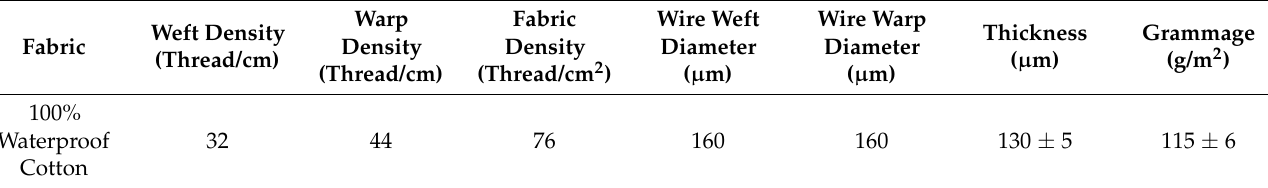
Table 2. Fabric characteristics (II): size and weight characteristics.